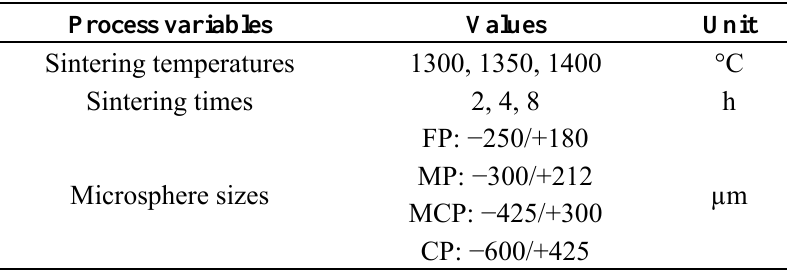
Table 1. Spherical powder sintering process